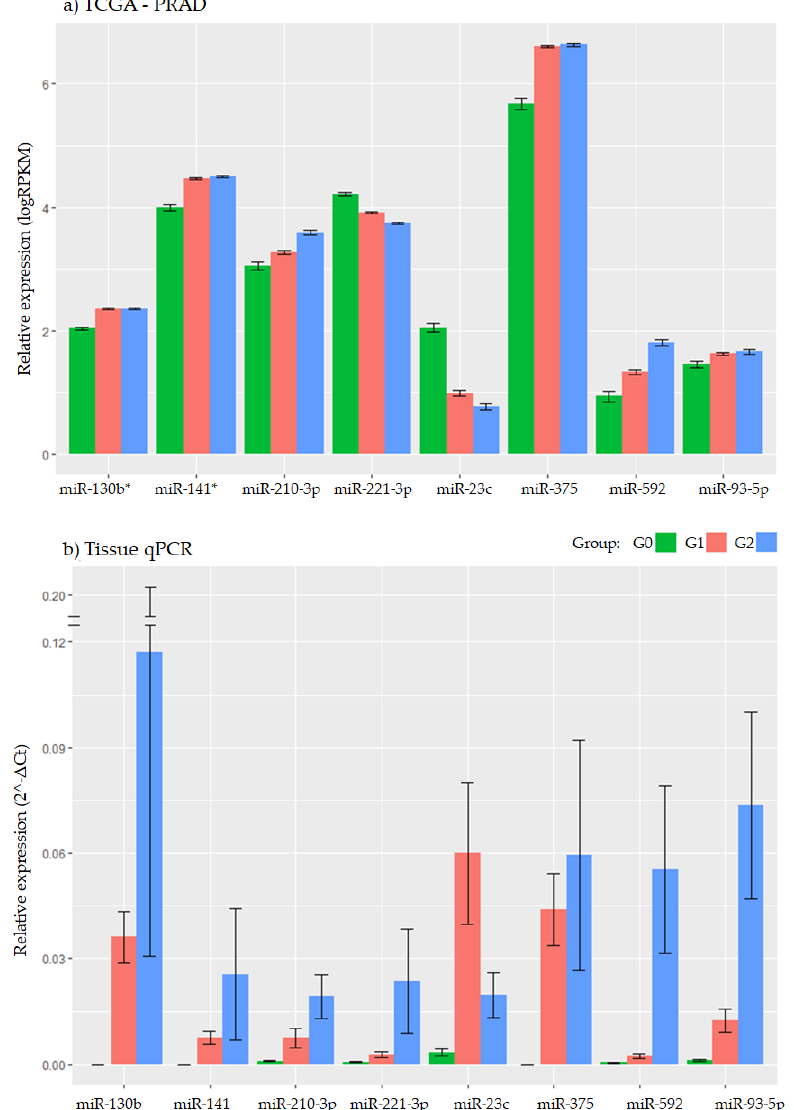
Figure 4. Bar chart of differential expression from qPCR versus TCGA data. ( a ) Plot showing differentially expressed miRNAs when comparing in TCGA (RPKM: Reads per Kilobase Million. * The values expressed in miR-141 and 130b include both -3p and -5p, to be able to compare with the qPCR results. ( b ) Plot showing differentially expressed miRNAs when comparing in qPCR analysis.